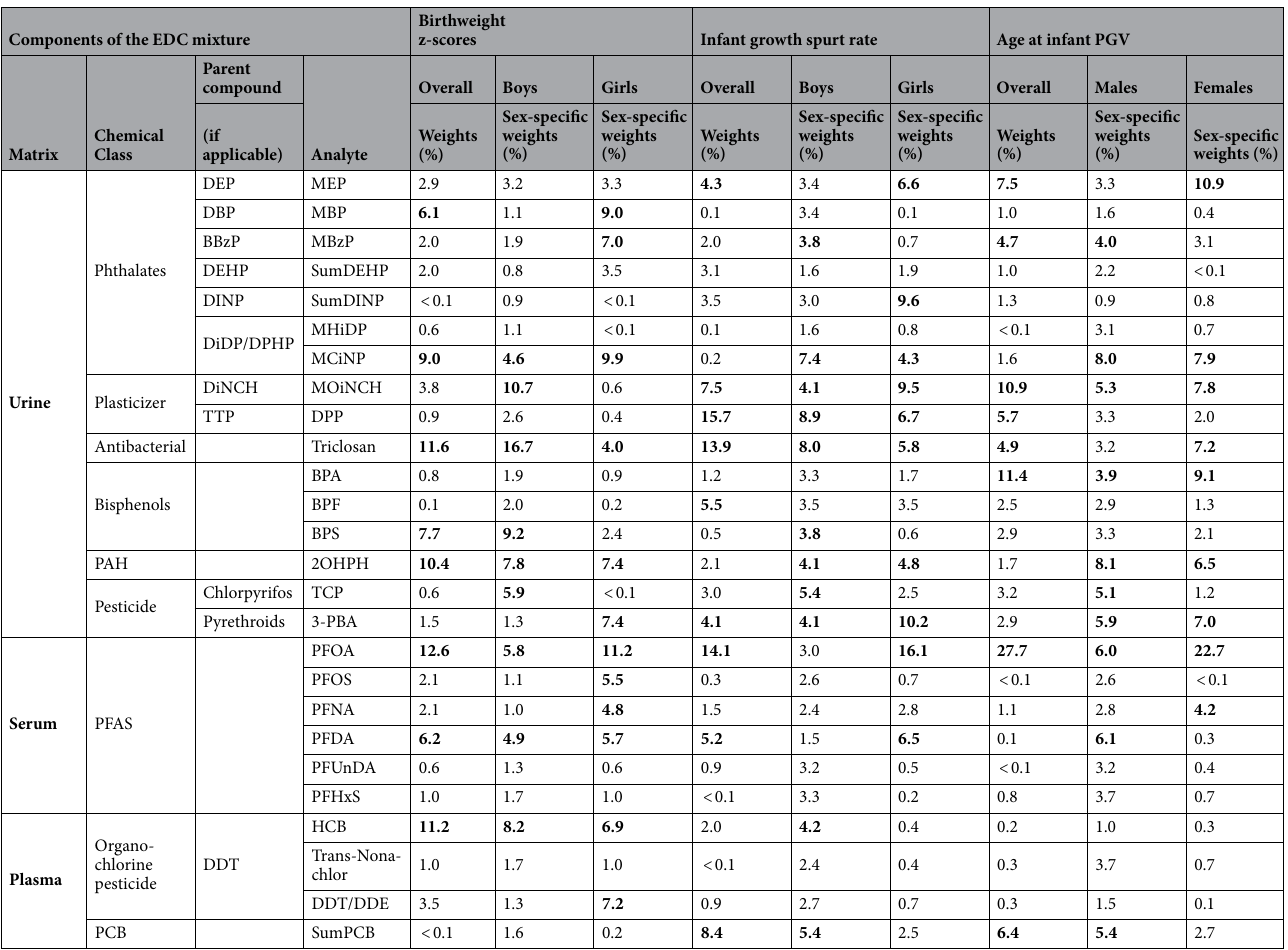
Table 4. Overall † and sex-specific weights ‡ in the WQS linear regression analysis between prenatal EDC mixture analysis and children’s growth characteristics, overall and by sex, n = 1,118. † Adjusted for maternal BMI, education, smoking, parity, child’s sex and gestational age at birth. Models with birthweight z-scores as outcome were not adjusted for sex or gestational age. Stratified models were not adjusted for sex. ‡ Weights represent the percentage attributable to each component of WQS index, and the sex-specific weights is that percentage calculated within each group (boys or girls). Chemicals with weights > 3.85% are marked in